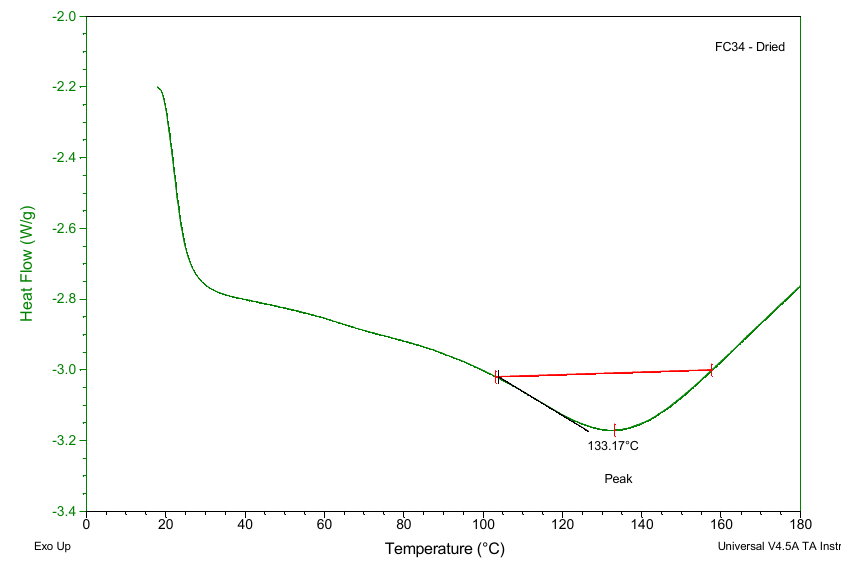
Figure 5. A representative DSC heating curve of a fully swollen chemically crosslinked hydrogel for analyzing its LCST.